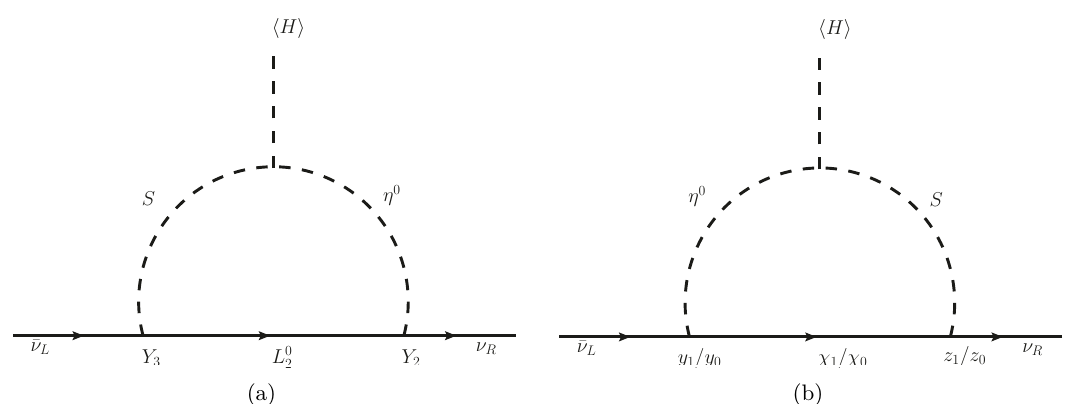
= − ( Y )sin θ , y = , Y 1 , z 1 0 , z 0 4( i 1) 6(1 i )